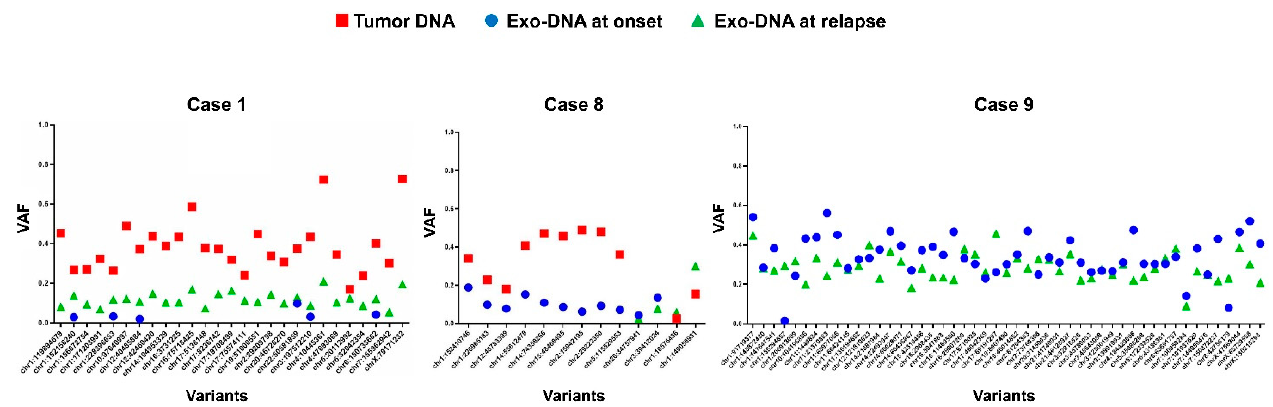
Figure 7. Frequency of the somatic SNVs in common between exo-DNA at relapse and tumor DNA/exo-DNA at onset. (VAF = variant allele frequency).